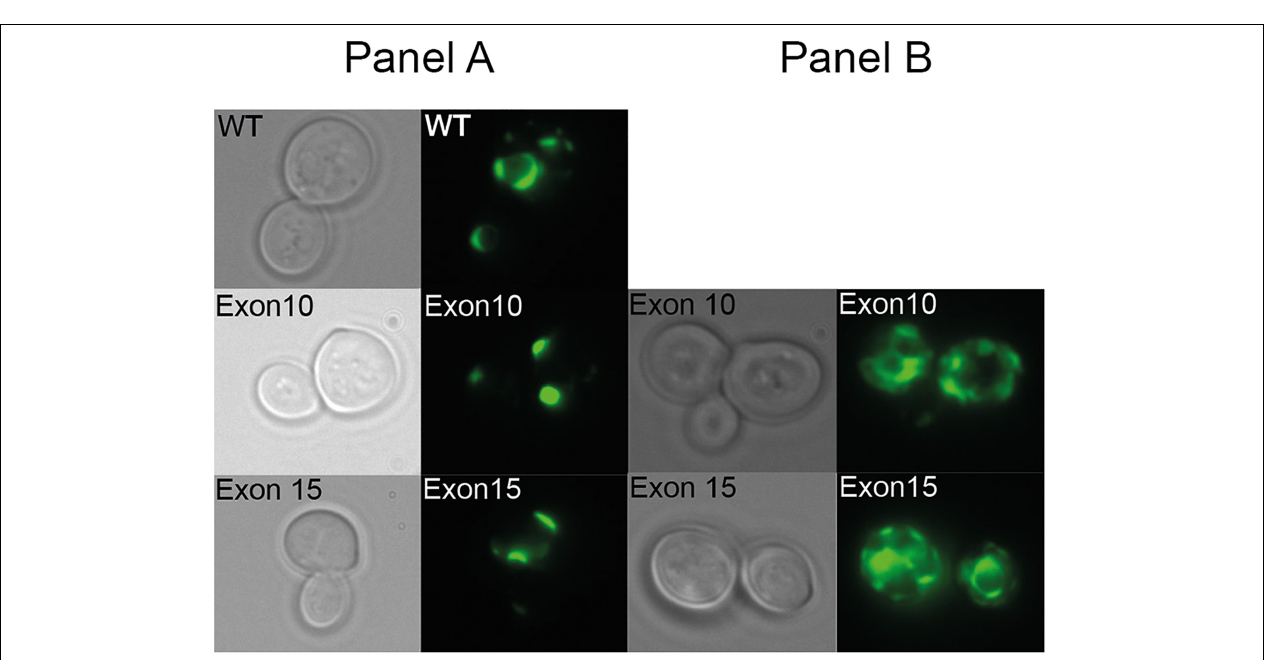
FIGURE 6 | Live cell bioimaging of the ccc2 (cid:49) yeast strain PAP6094 expressing green fluorescent protein (GFP)-tagged wild-type ATP7A, exon10 or exon15 missing ATP7A variants. Yeast cultures were grown at 30 ◦ C in galactose minimal medium overnight prior to live cell bioimaging as described in the Materials and Methods section. Representative images of the two observed classes panels (A,B) of cells expressing ATP7A variants missing exon 10, or exon 15 in addition to cells expressing wild-type ATP7A panel (A) are shown. For each ATP7A variant, a phase-contrast image and the corresponding GFP image are